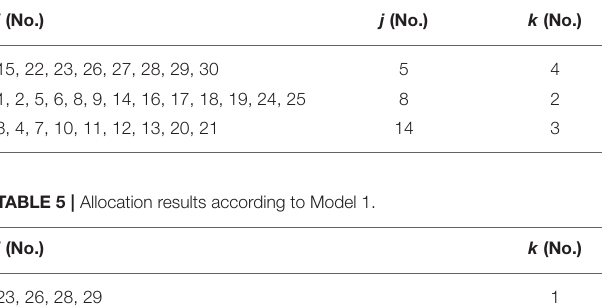
TABLE 4 | Location and allocation results according to Model 1.